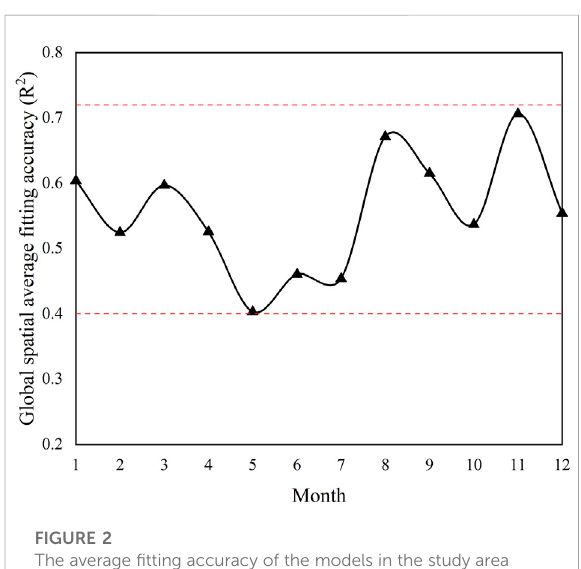
FIGURE 2 The average fi tting accuracy of the models in the study area from 2016 to